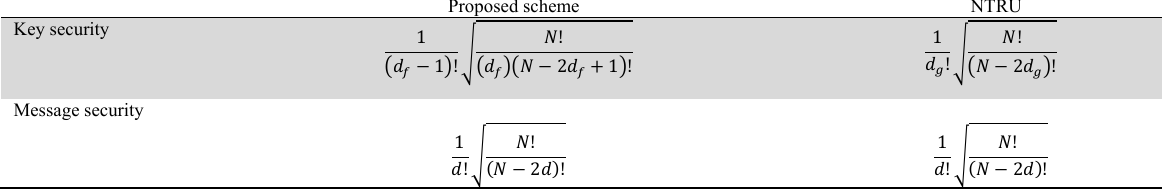
The Key and Message Security of the Proposed Scheme and the NTRU